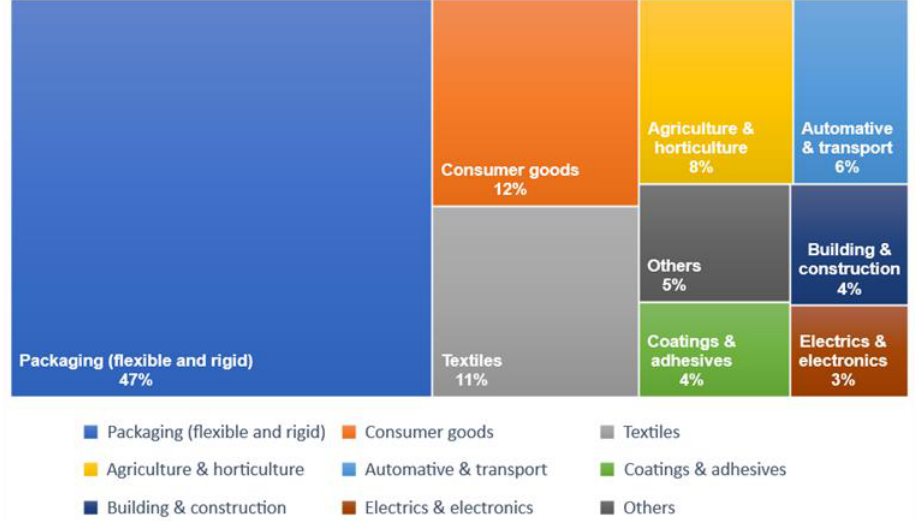
Figure 2. Distribution by sector of the bioplastics global production market in 2020 (total of 2.11 million tons). Even with this high demand for biobased materials, some challenges must be over- come. Some examples may be